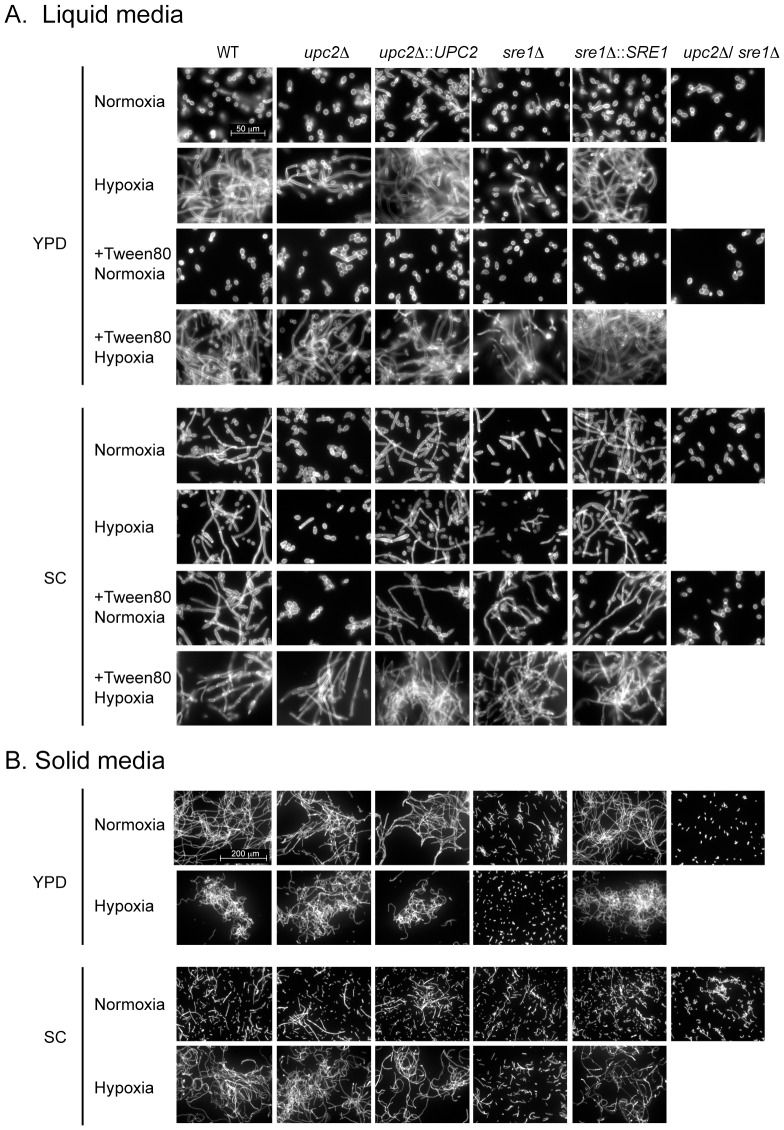
YlSre1 and YlUpc2 regulate filamentation.(A) Wild type (JMY2900), Ylupc2 deletion (SMY2) and UPC2 re-integration (SMY6), Ylsre1 deletion (SMY5) and YlSRE1 re-integration (SMY7), and ylupc2/Ylsre1 double deletion (SMY4) strains were grown overnight in liquid YPD or liquid SC media containing methionine, in normoxic or hypoxic (1% O2) conditions. Tween80 (1%) was added where indicated. The cells are stained with Calcofluor White. (B) The strains listed in (A) were grown on solid YPD or SC media in hypoxic or normoxic conditions for 2 days. Cells were removed from individual colonies, stained with Calcofluor White, and photographed.